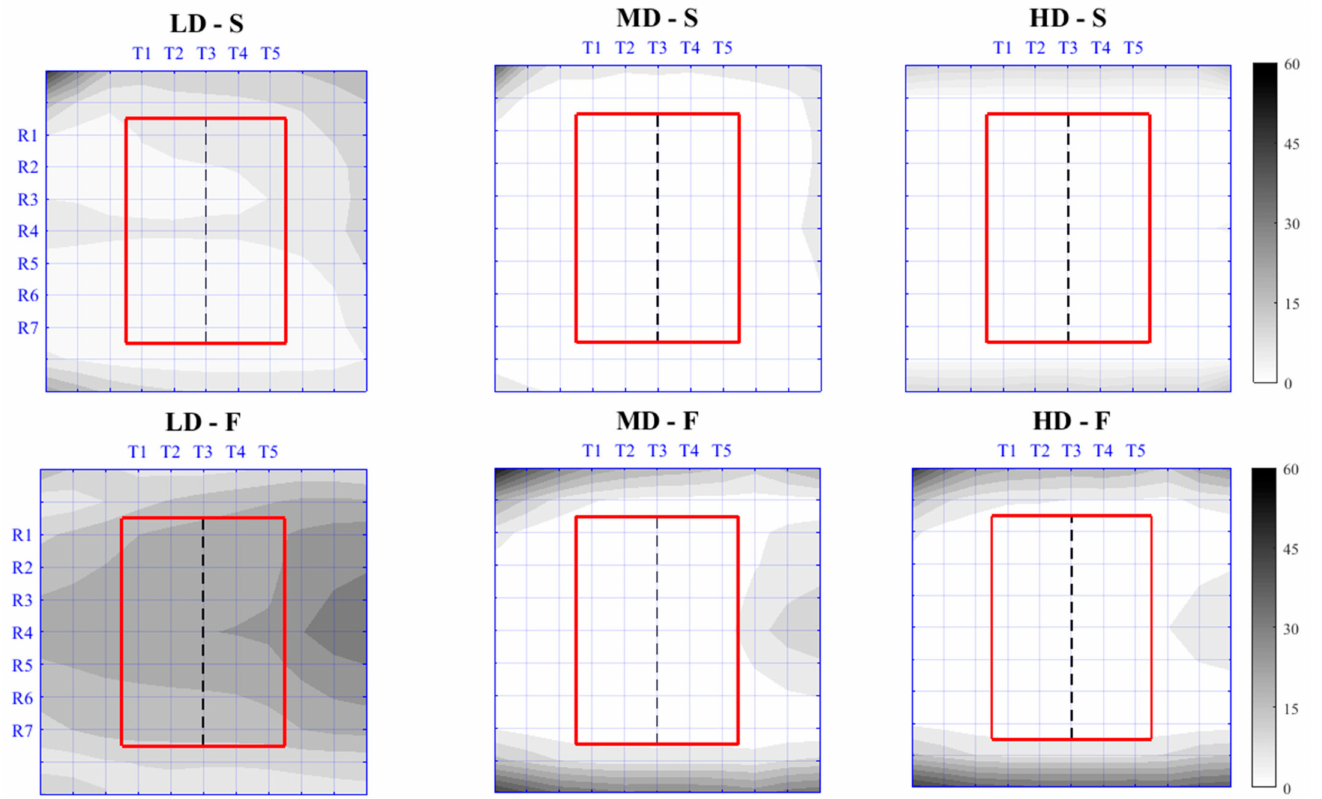
Figure 5. Map of < APE i > for all the scenarios under the ID-CON scheme (first set of simulations: frame-rate = 4 fps, d = 30 s). The six scenarios are characterized by different configurations, given by the combination of the three densities (LD, MD and HD) with the two surface velocity profiles (S- and F-profile). < APE i > is the mean APE i (Absolute Percentage Error) over the 100 replications per scenario at the generic node i . The central area of investigation (250 × 350 px) is highlighted by red contour, while the vertical black dashed line identifies the reference transect T3. R1, R2, . . . , R7 refer to the rows of the computational grid within the area of investigation, while T1, T2, . . . , T5 refer to the columns (cross section